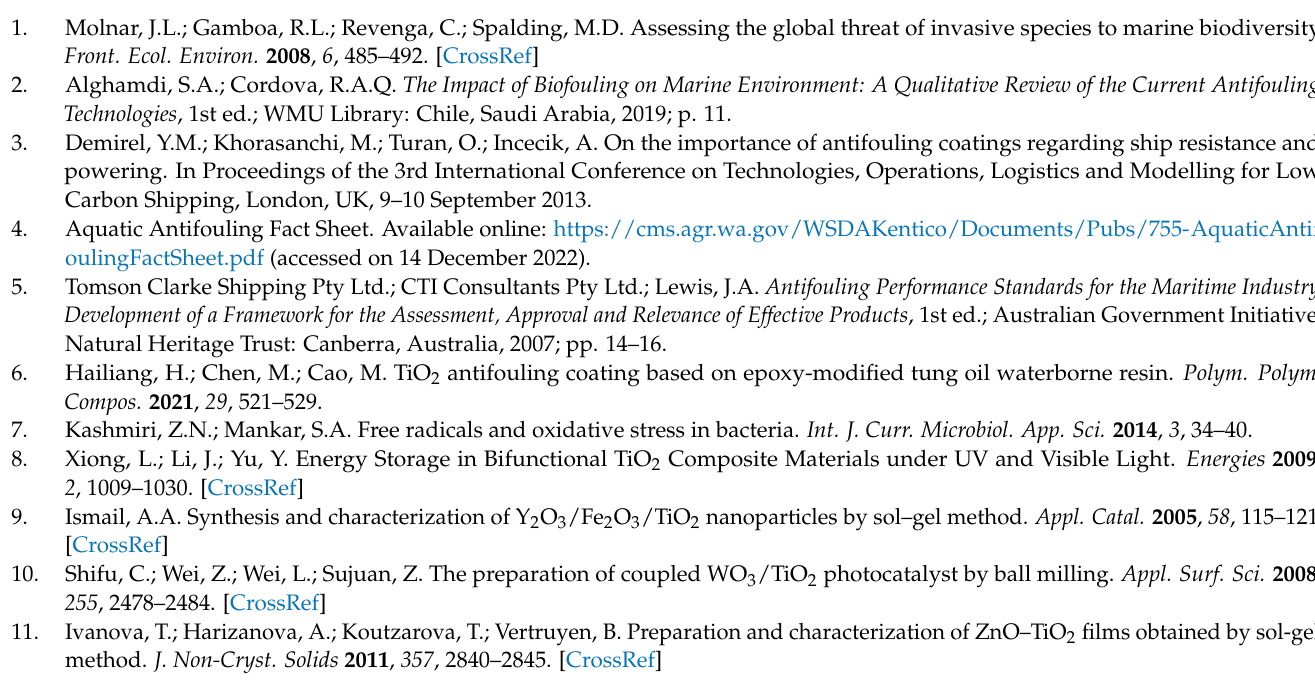
Munk vs. absorption energy plots ( b ) of the mixed metal oxides (TiO 2 /WO 3 and TiO 2 /PTh/WO 3 ); Figure S5: High-resolution XPS spectra of various metal oxides; images ( a – e ) present Ti 2p spectra of TiO 2 ( a ), 1%WO 3 @TiO 2 ( b ), 3%WO 3 @TiO 2 ( c ), 5%WO 3 @TiO 2 ( d ), and 10%WO 3 @TiO 2 ( e ), respectively. Images ( f – i ) present W 4f spectra of 1%WO 3 @TiO 2 ( f ), 3%WO 3 @TiO 2 ( g ), 5%WO 3 @TiO 2 ( h ), and